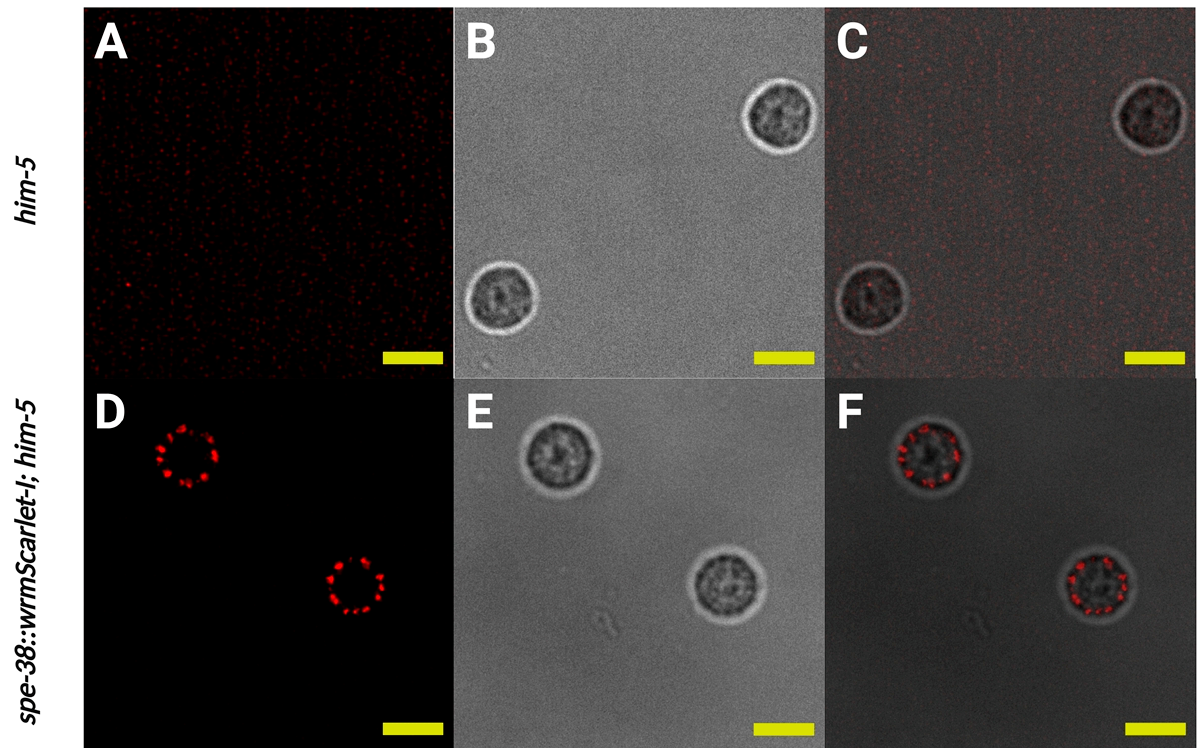
Figure 3. Localization of SPE-38::wrmScarlet-I visualized by red fluorescent signal to membranous organelles (MOs) in spermatids. ( A – C ) Imaging of the same control spermatids dissected from him-5(e1490) males. ( A ) Single confocal section of control spermatids. ( B ) Bright field image of control spermatids. ( C ) Merge of ( A , B ). ( D – F ) Imaging of spe-38::wrmScarlet-I ; him-5(e1490) spermatids dissected from males. ( D ) Single confocal section of spe-38::wrmScarlet-I ; him-5(e1490) spermatids. ( E ) Bright field image of spe-38::wrmScarlet-I ; him-5(e1490) spermatids. ( F ) Merge of ( D , E ). Yellow scale bars, 5 µm.